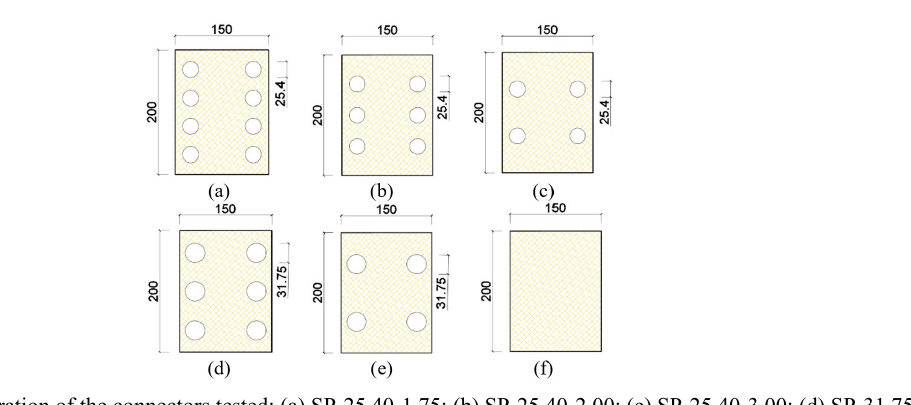
Figure 7. Hole configuration of the connectors tested: (a) SP-25.40-1.75; (b) SP-25.40-2.00; (c) SP-25.40-3.00; (d) SP-31.75-2.00; (e) SP-31.75-3.00; (f)